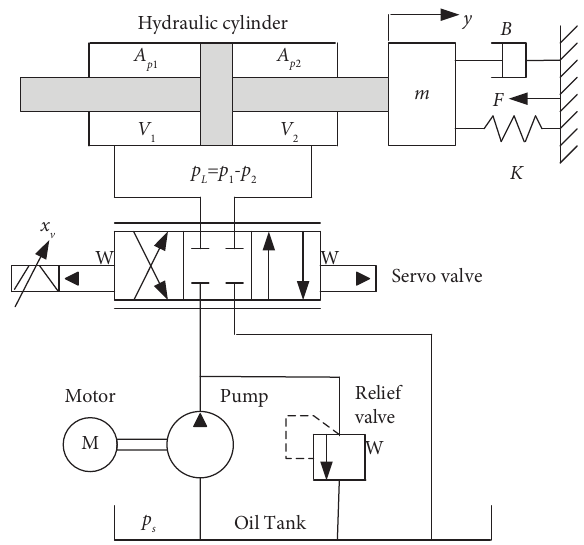
Figure 1: Schematic diagram of the electro-hydraulic servo